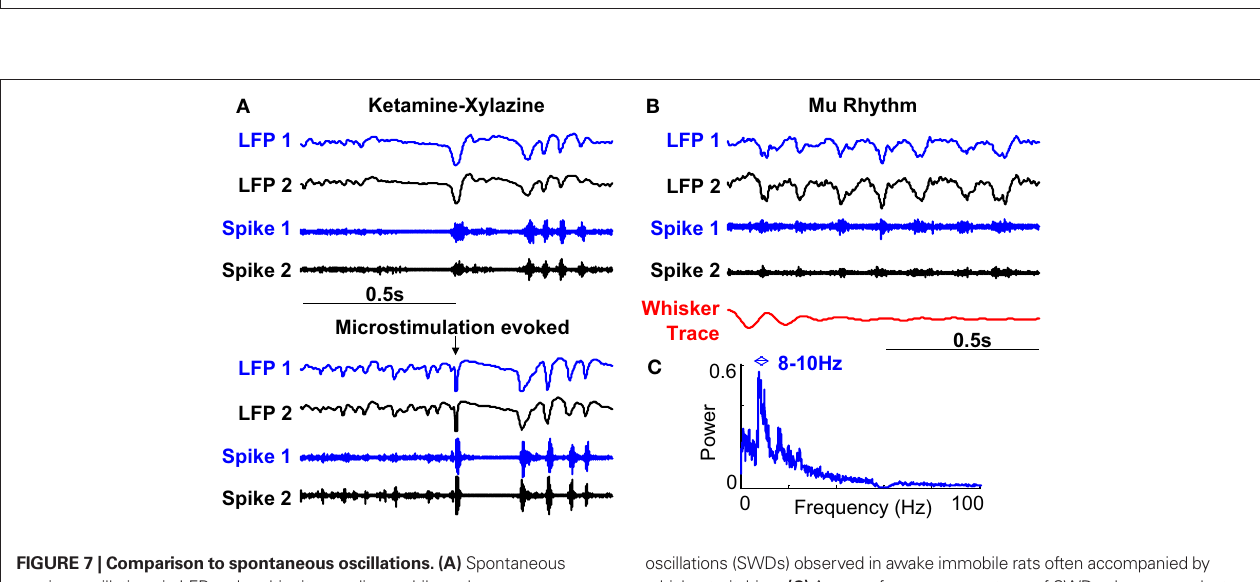
FIGURE 6 | Amplitude of stimulation. (A) Scatter plot, raster and average of the LFP response to cortical microstimulation at 10 µA. The correlation coeffi cient between whisking strength and strength of evoked oscillations is